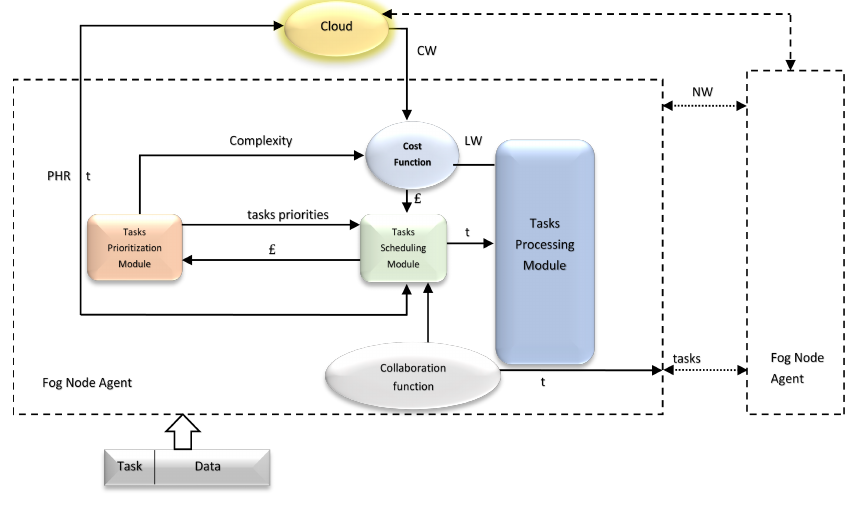
Figure 4. Fog node